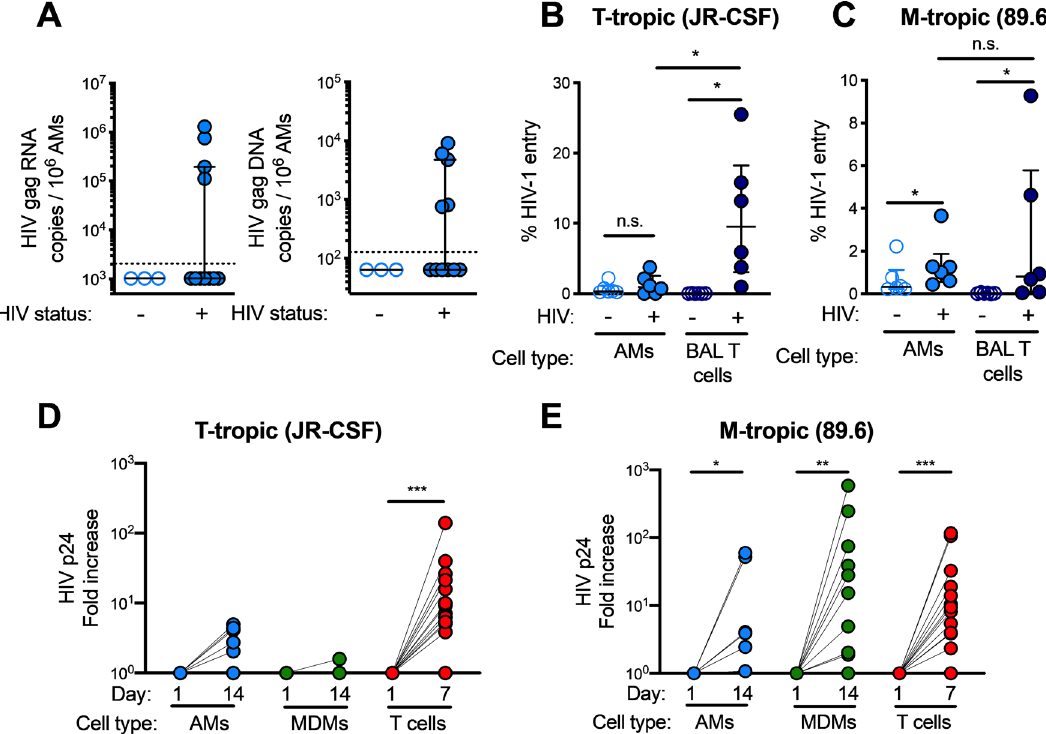
Figure 1. HIV RNA and DNA can be detected in AMs despite low T-tropic HIV entry and replication rates. ( A ) HIV Gag RNA and DNA are detectable in alveolar macrophages (AMs) from individuals with untreated HIV infection. HIV Gag RNA or DNA copies per cell by qRT-PCR in AMs from the Cape Town cohort. Dashed lines denote the limit of detection for the assay, and negative values are plotted at 50% of the limit of detection. ( B , C ) Viral entry was detected in AMs and BAL CD4+ T cells from HIV-uninfected subjects using gravity infection for 12 h with a BLaM-Vpr construct (HIV+) of JR-CSF ( B ) or 89.6 ( C ) or mock infection (HIV-) at a multiplicity of infection (MOI) of 1. HIV entry was detected by cleavage of a fluorescent BLaM substrate and measured by flow cytometry; n = 6. ( D , E ) CD4+ T cells, MDMs and AMs were infected with replication- competent JR-CSF ( D ) or 89.6 ( E ) at a MOI of 0.2 for 12 h. HIV p24 levels in the supernatant were measured by ELISA at the indicated time points and normalized to input at day 1; n = 11 for T cells, n = 12 for MDMs, and n = 6 for AMs. Statistics were done by Kruskal–Wallis tests with Dunn’s multiple test correction in B and C. * p < 0.05, ** p < 0.01, *** p <